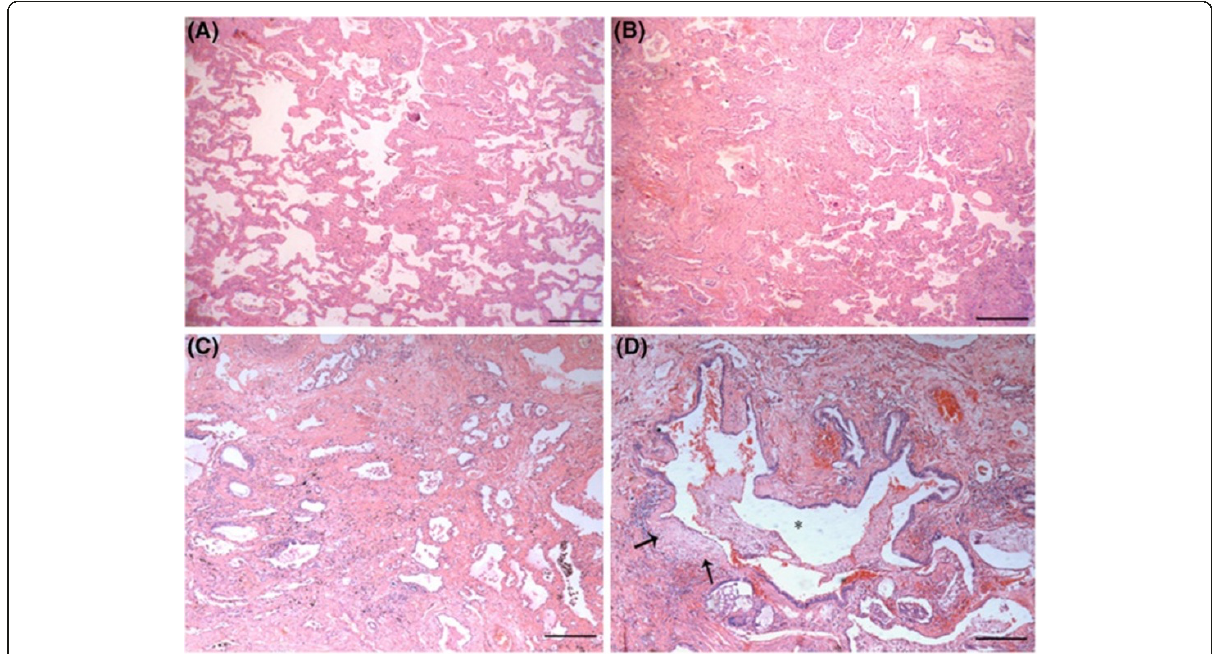
Figure 3 Microscopic features of the patient's lung upper lobe. Under low power microscope, some alveolar septum of apicoposterior segment of upper lobe(from where labeled “ a ” in Figure 2 ) had more lymphocyte and plasmocyte infiltrated, alveolar wall was mild broadening, but absent evident of fibrous hyperplasia which looks like pattern of NSIP cellular type ( A ); Some alveolar wall had fibre hyperblastosis obviously , a few collagen deposited and lymphocyte infiltrated as picture of NSIP mix type ( B ) and fibrotic type ( C ) ; The fiber interval of subpleural aera of anterior segment (from where labeled “ b ” in Figure 2 ) was thickening clearly, bronchiole epithelium had metaplasia and cystic fibrous gas cavity was formed (*), several cystic wall had small fibroblast foci (solid arrow), The appearance was extremely like UIP ( D ). ( H&E stain,